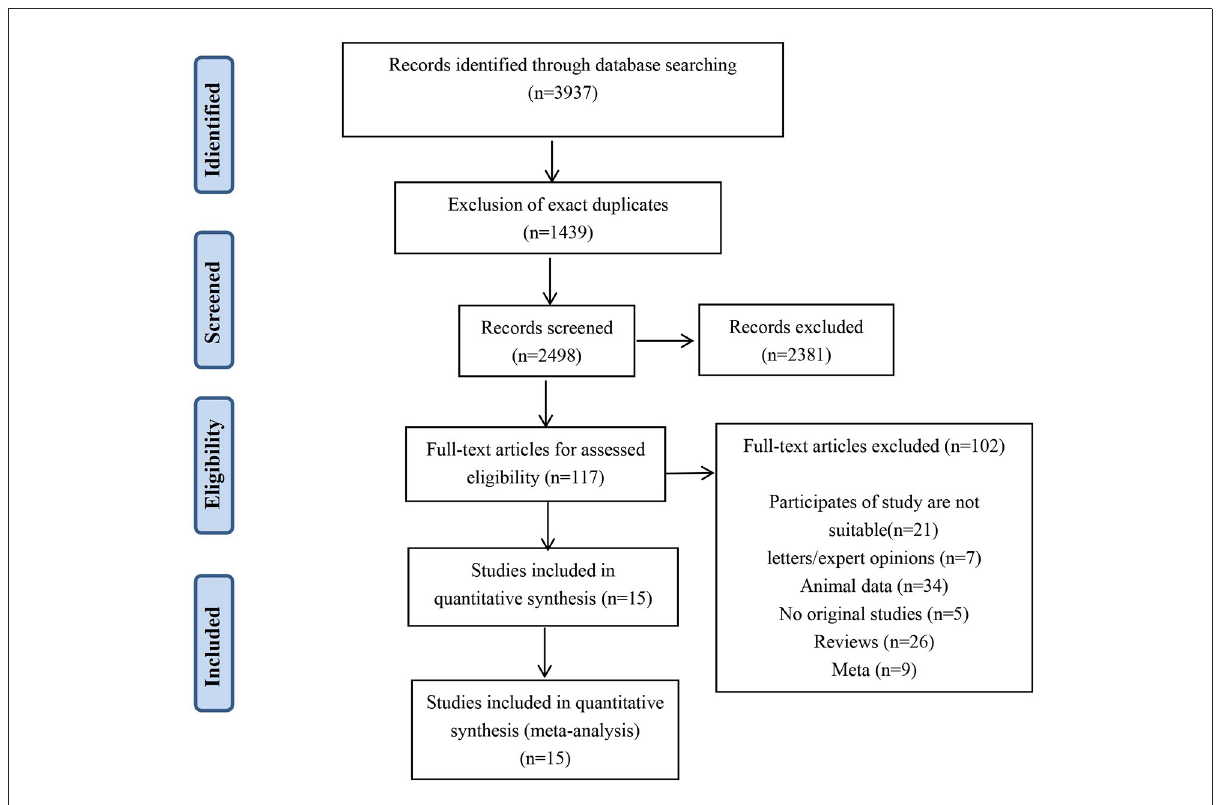
FIGURE1 Study selection flow diagram according to the PRISMA guidelines.